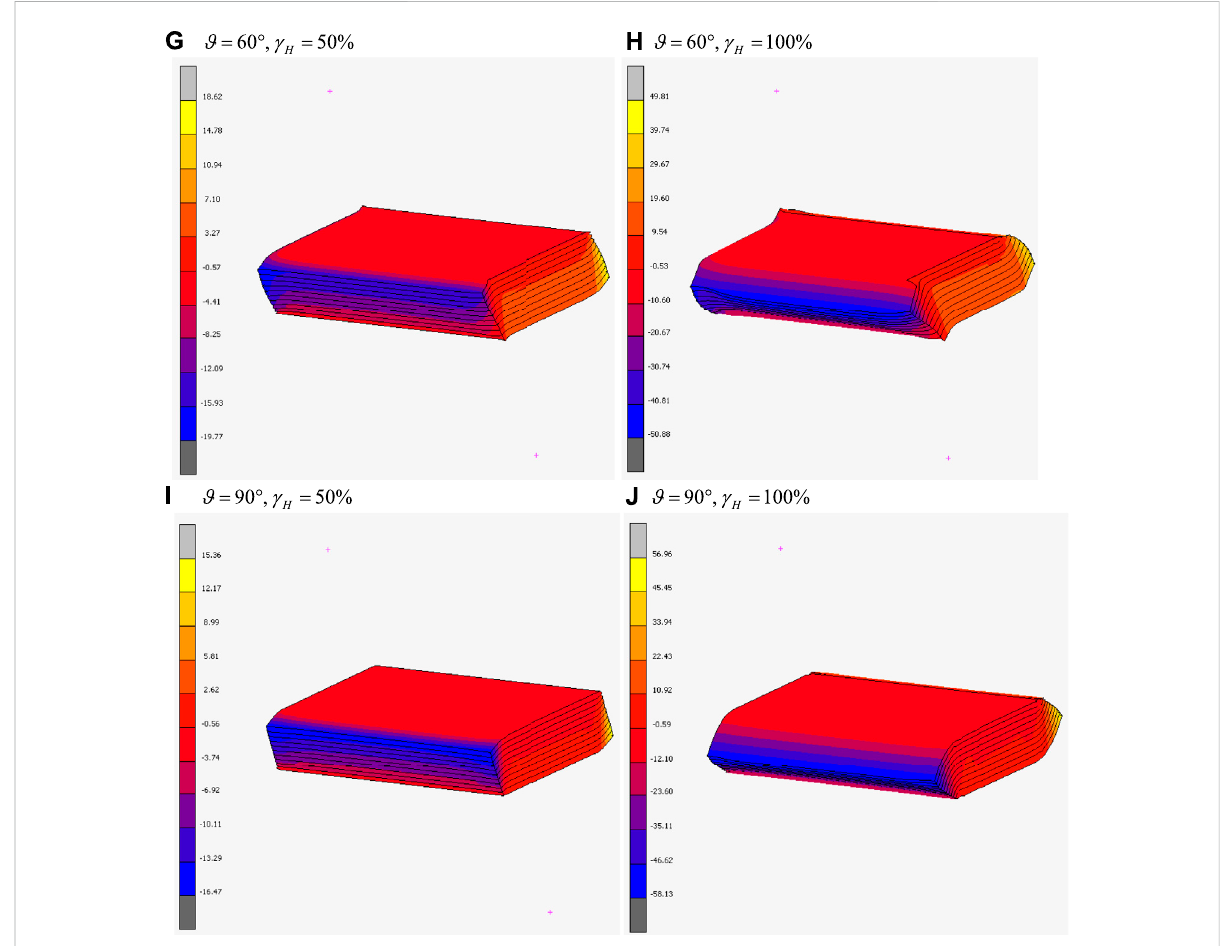
FIGURE 4 (Continue). Vertical displacements of a sample bearing at γ ϑ H (cid:1) 50% (Figures 3A,C,E,G,I) and γ ϑ H (cid:1) 100% (Figures